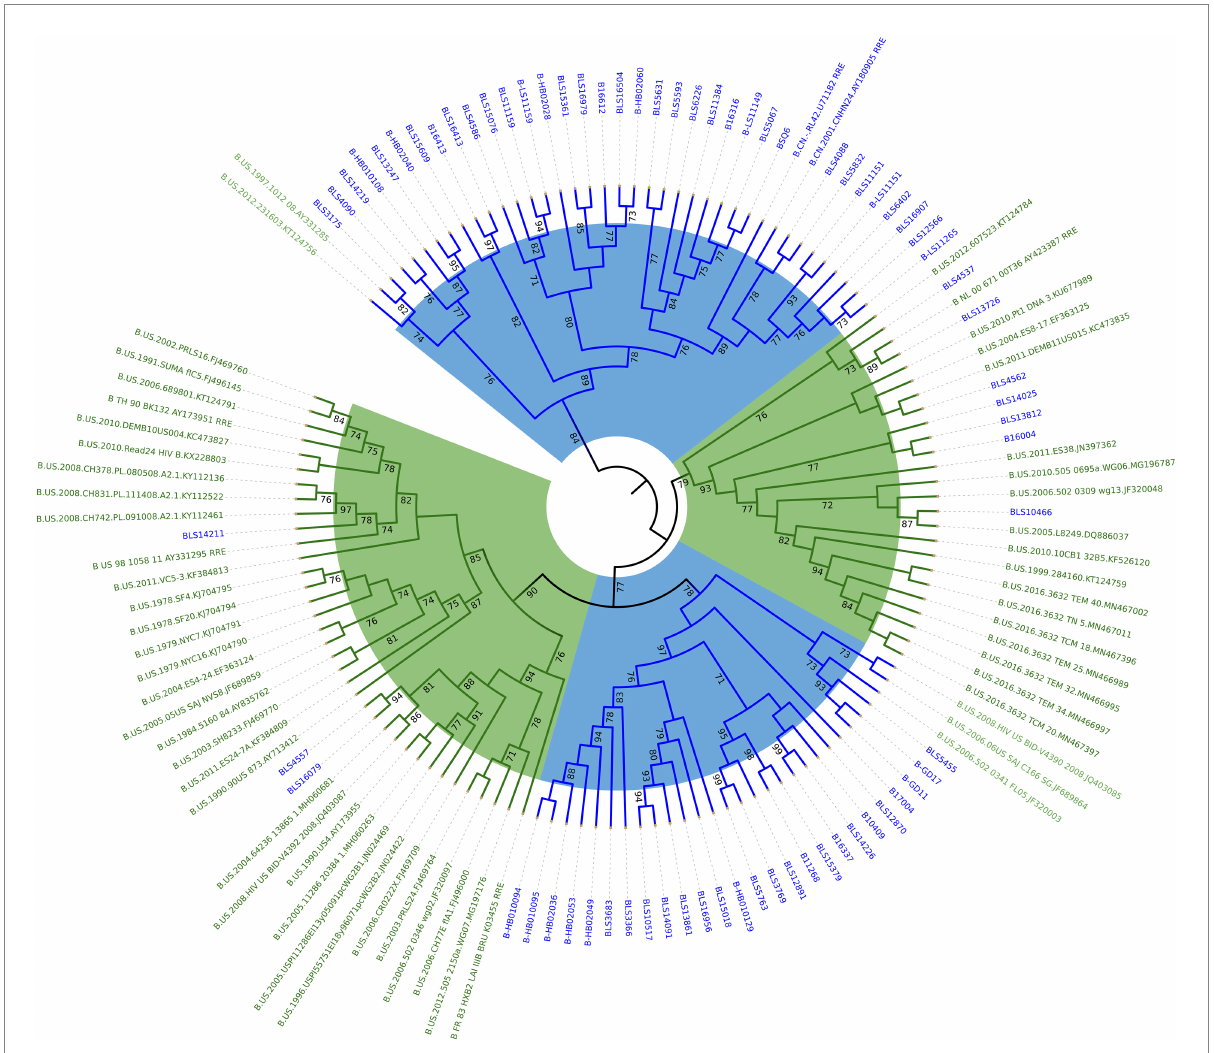
FIGURE 2 Phylogenetic analysis of HIV-1 subtype B RRE in China and the United States. Using the maximum likelihood method to construct the tree, the percentage of replicate trees in which the relevant taxa are clustered together in the bootstrap test (1,000 replicates) is shown next to the branches. The subtype B circulating in China is marked in blue and the American subtype B is marked in green.